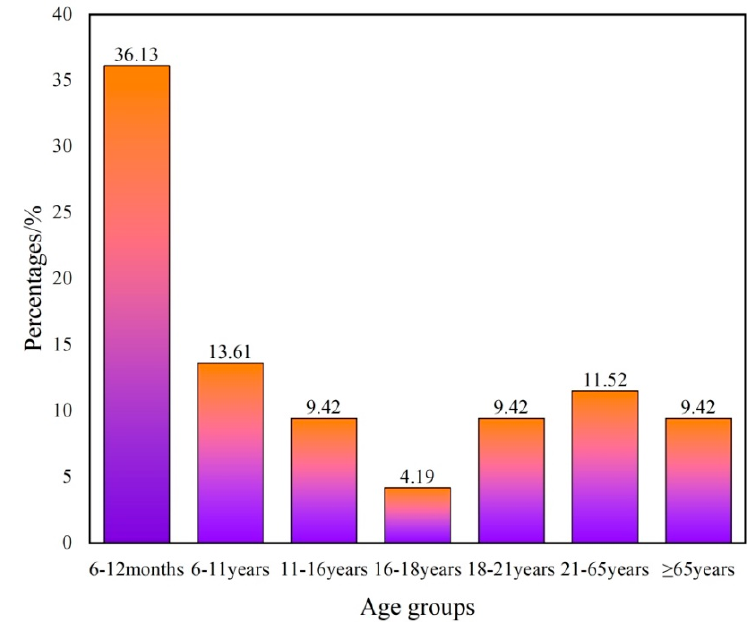
Figure 8. Percentage bar graph of the hazard indices of the different age groups exceeding the acceptable limit of HI = 1.